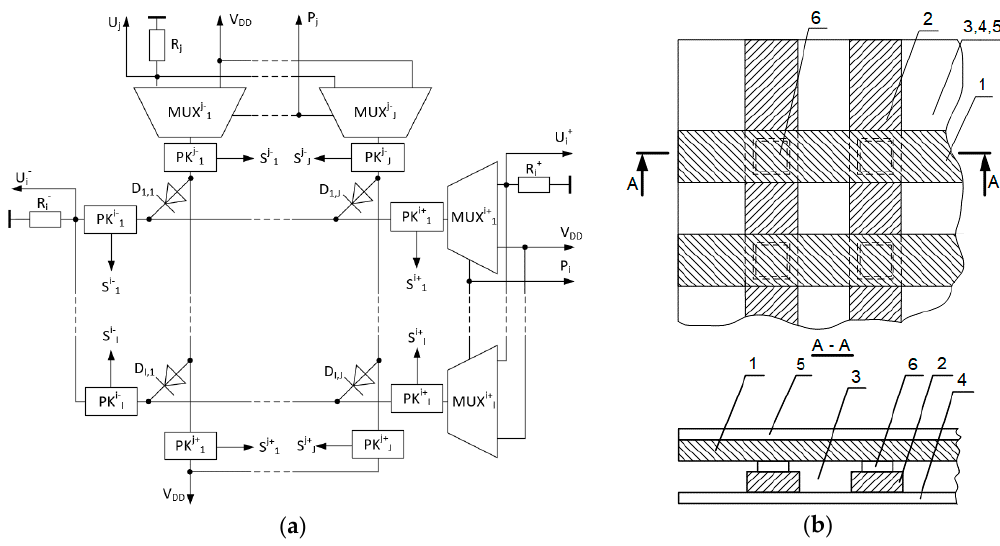
Figure 1. The functional scheme and the design of the distributed crack sensor: ( a ) The functional scheme of the distributed crack sensor; ( b ) The design of the distributed crack sensor (1—thin film conductors of the first layer; 2—thin film conductors of the second layer; 3–5—dielectric films; 6—diodes). MUX: multiplexers; PK: passkeys.